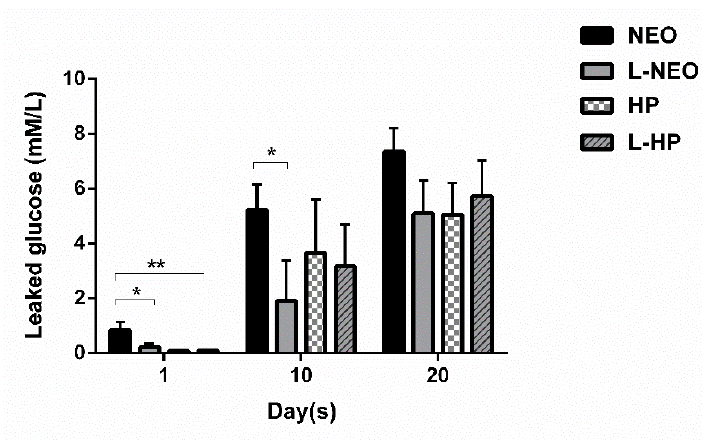
Figure 6. Glucose leakage across experimental groups at 1st, 10th, and 20th days. Results are expressed as mean values + SEM. Kruskal–Wallis, and Dunn’s post-hoc test was used for statistical analysis to compare the results across groups at 1st, 10th, and 20th days. (**, p < 0.01; *, p < 0.05; no asterisks, not significantly different).